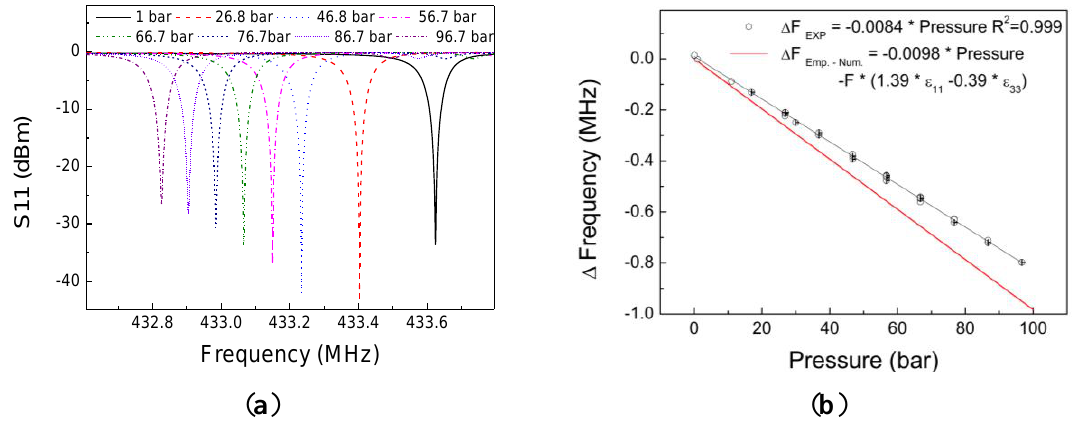
Figure 4. ( a ) S11 curve for all applied pressures. ( b ) Comparison of the variation of the SAW resonance frequency as a function of pressure calibration curve at ambient temperature (25 ℃ ).